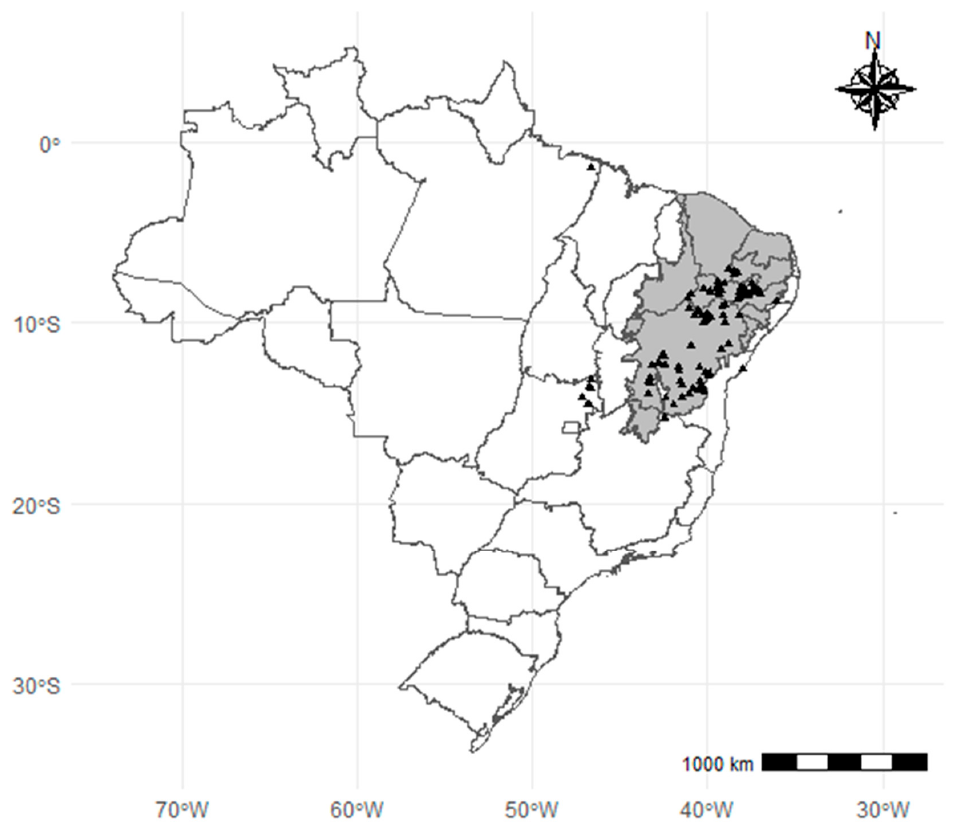
Figure 2. Geographical distribution of identified Schinopsis brasiliensis Engl specimens from the Reflora Virtual Herbarium collection found in Brazil. (Map plotted using RStudio 1.4 with ‘geobr’ and ‘ggspatial’ packages).